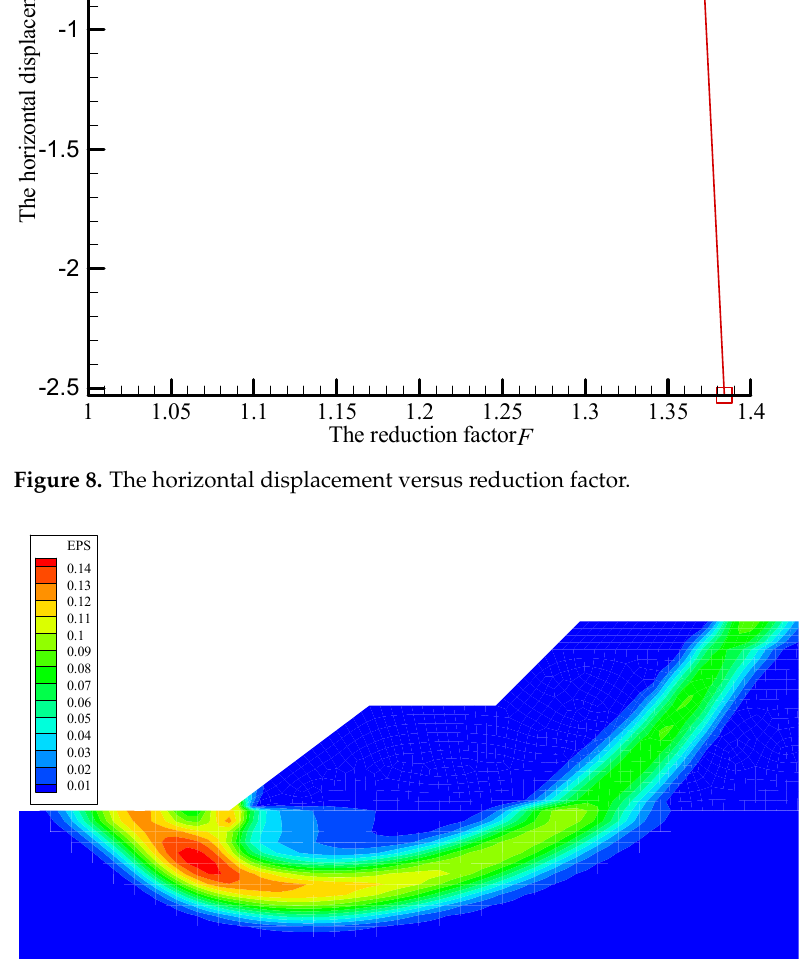
Figure 9. Distribution of equivalent plastic strain at the top corner of the slope.